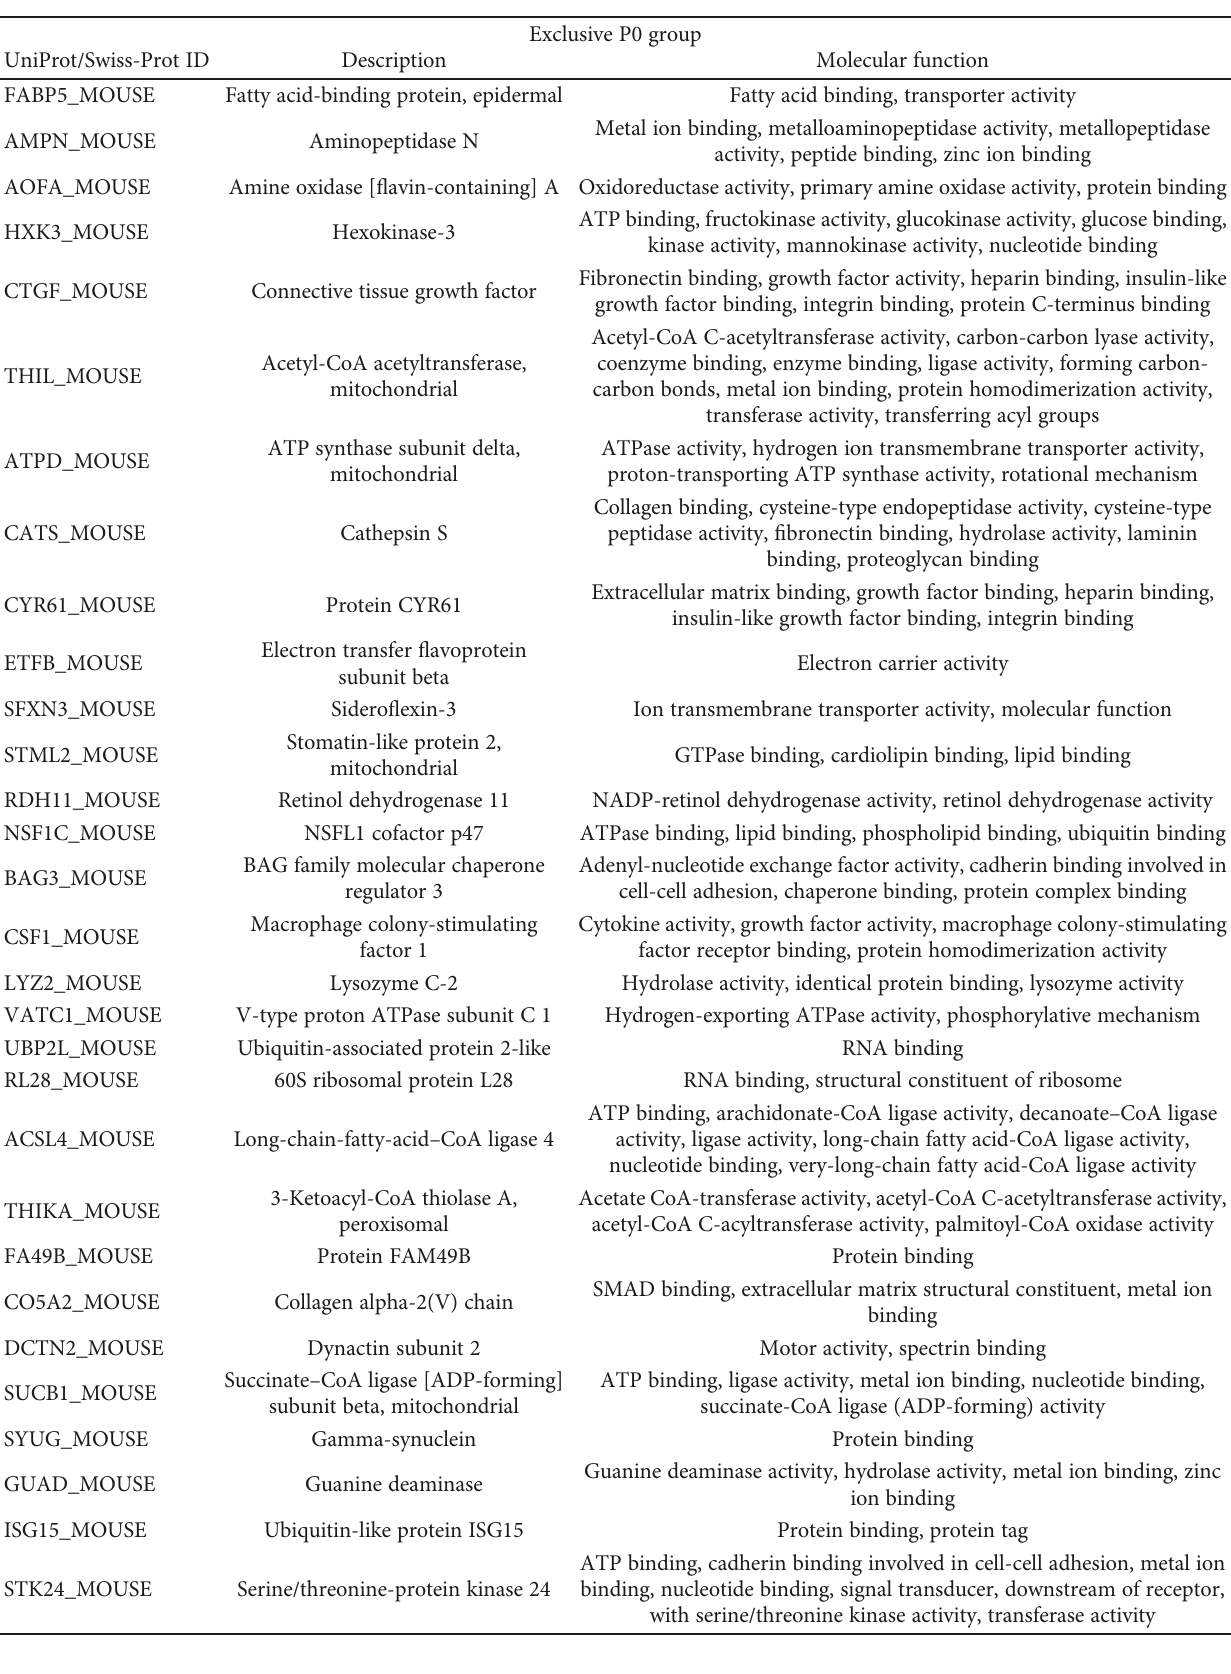
Table 3: Identi fi cation of endogenous proteins contained in mMSC-AT_P0 only, not in